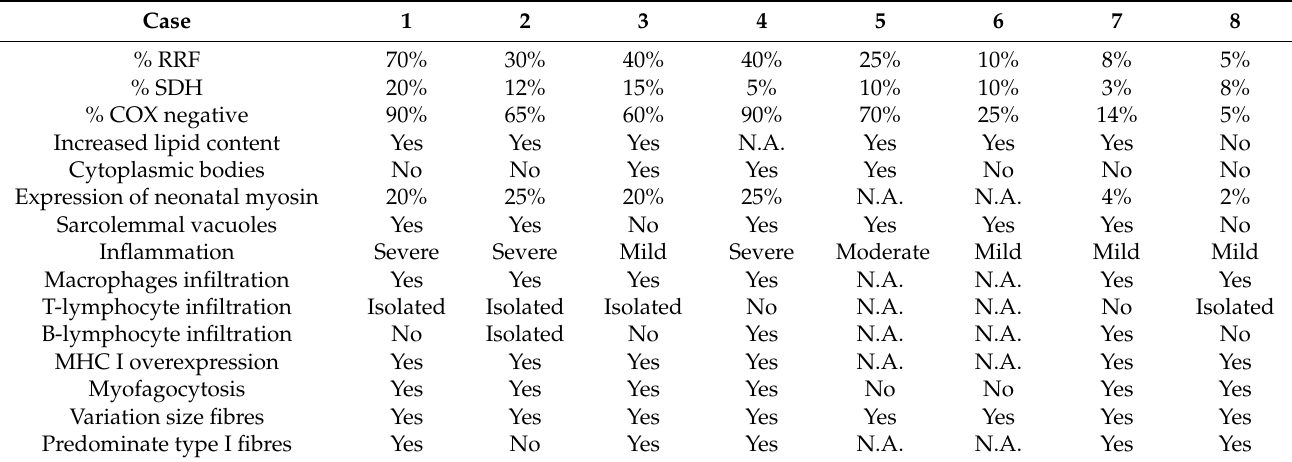
Table 1. Histopathological (n = 8) features in the muscle biopsies from paediatric patients with TK2